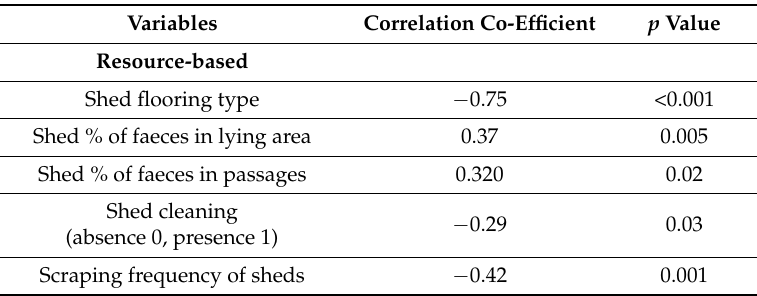
Table 6. Spearman’s rank correlations between coefficient of friction of shelter flooring and resource- and animal-based variables with p -values ≤